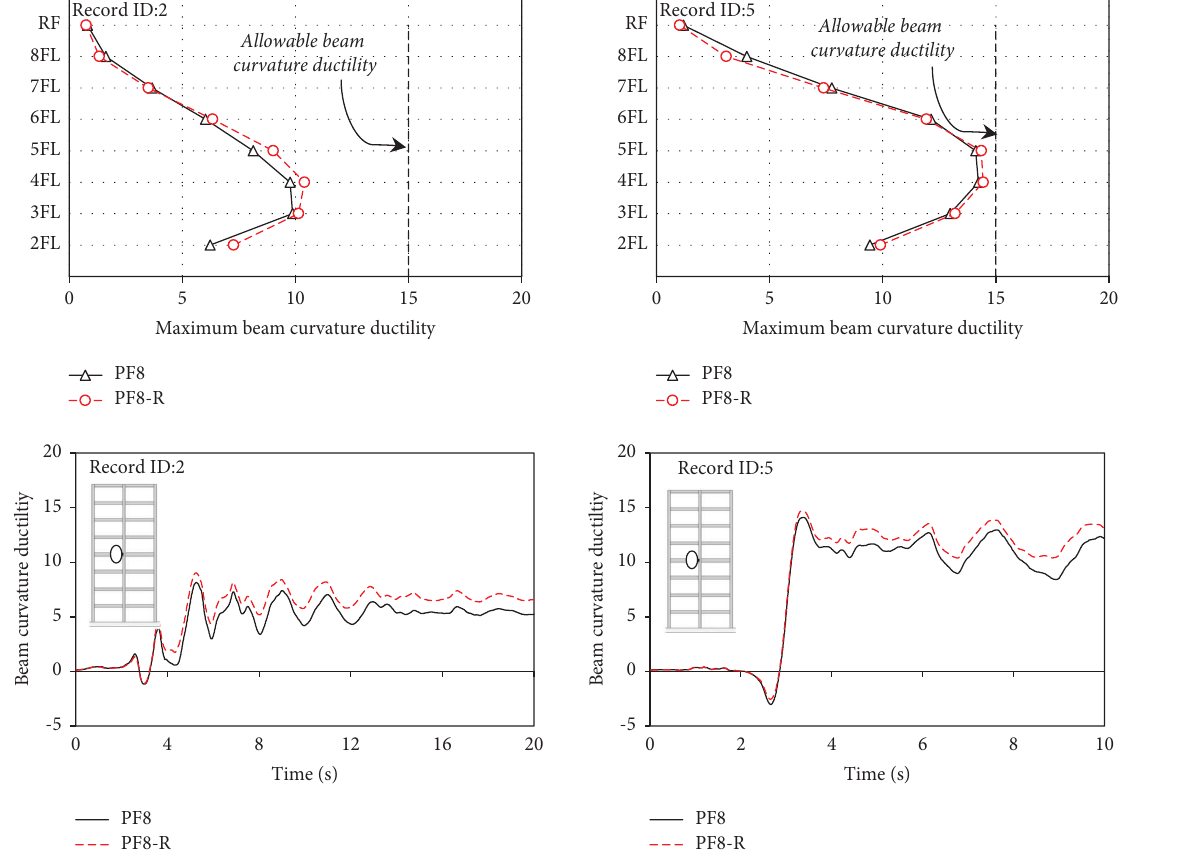
Figure 17: Maximum curvature ductility demands placed upon the beams of the eight-story frames subjected to Kobe and Northridge earthquake ground